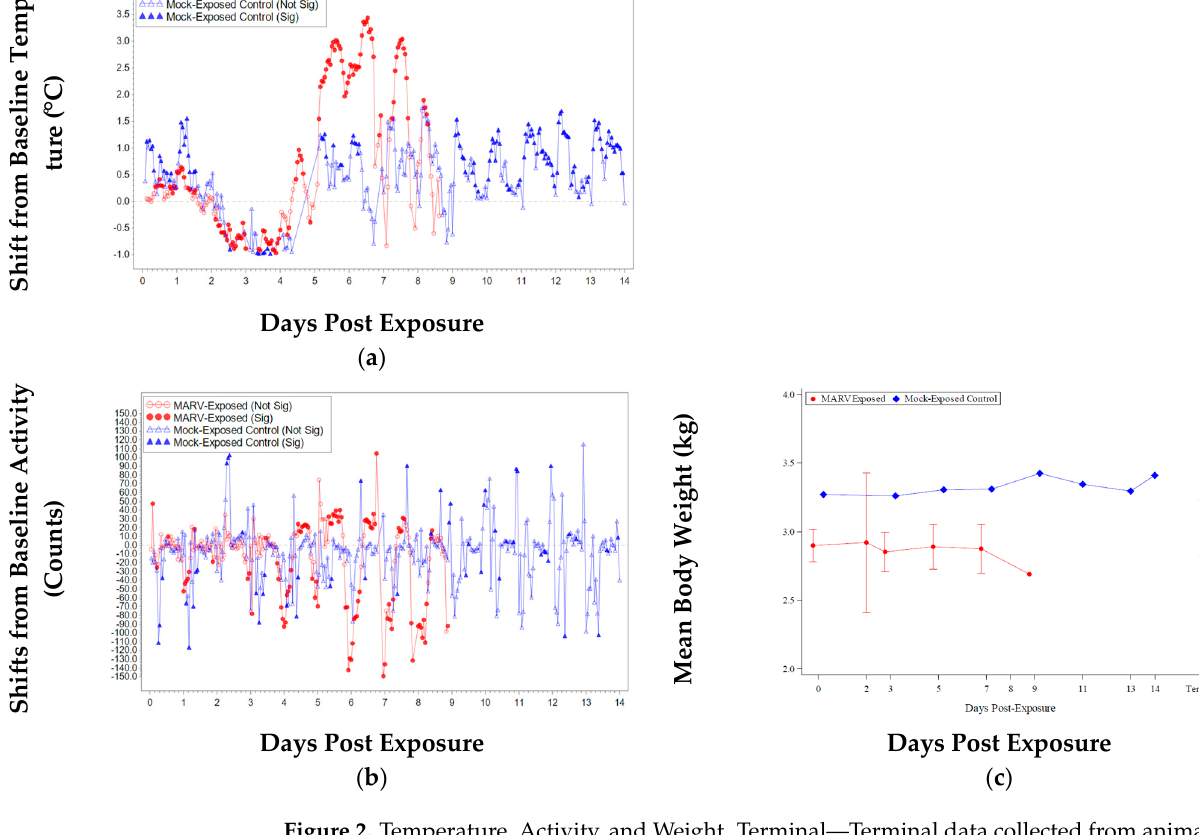
Figure 2. Temperature, Activity, and Weight. Terminal—Terminal data collected from animals that met euthanasia criteria (unscheduled euthanasia) or were found dead were combined and reported as a single time point. ( a ) Least-Square Means Plot for Shift from Baseline Body Temperature (°C) from telemetry. ( b ) Least-Square Means Plot for Shift from Baseline Activity (Counts). ( c ) Plot of Mean Body Weight (kg) with 95% Confidence Interval Over Time (Confidence interval was not plotted for sample size less than